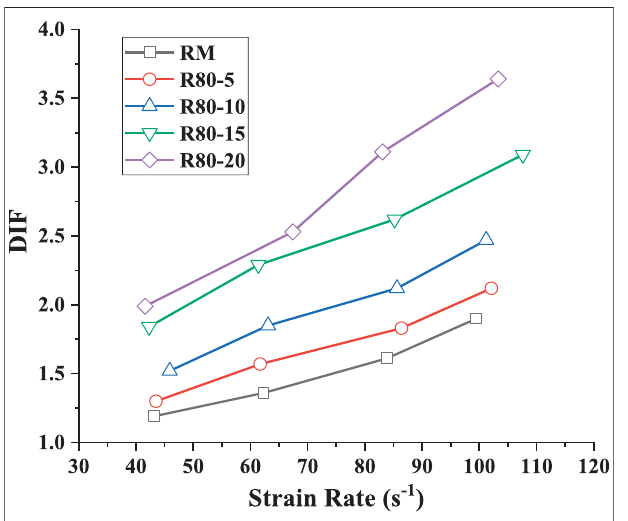
FIGURE 16 | Relationship between DIF and strain rate of rubber mortar with different sizes of crumb